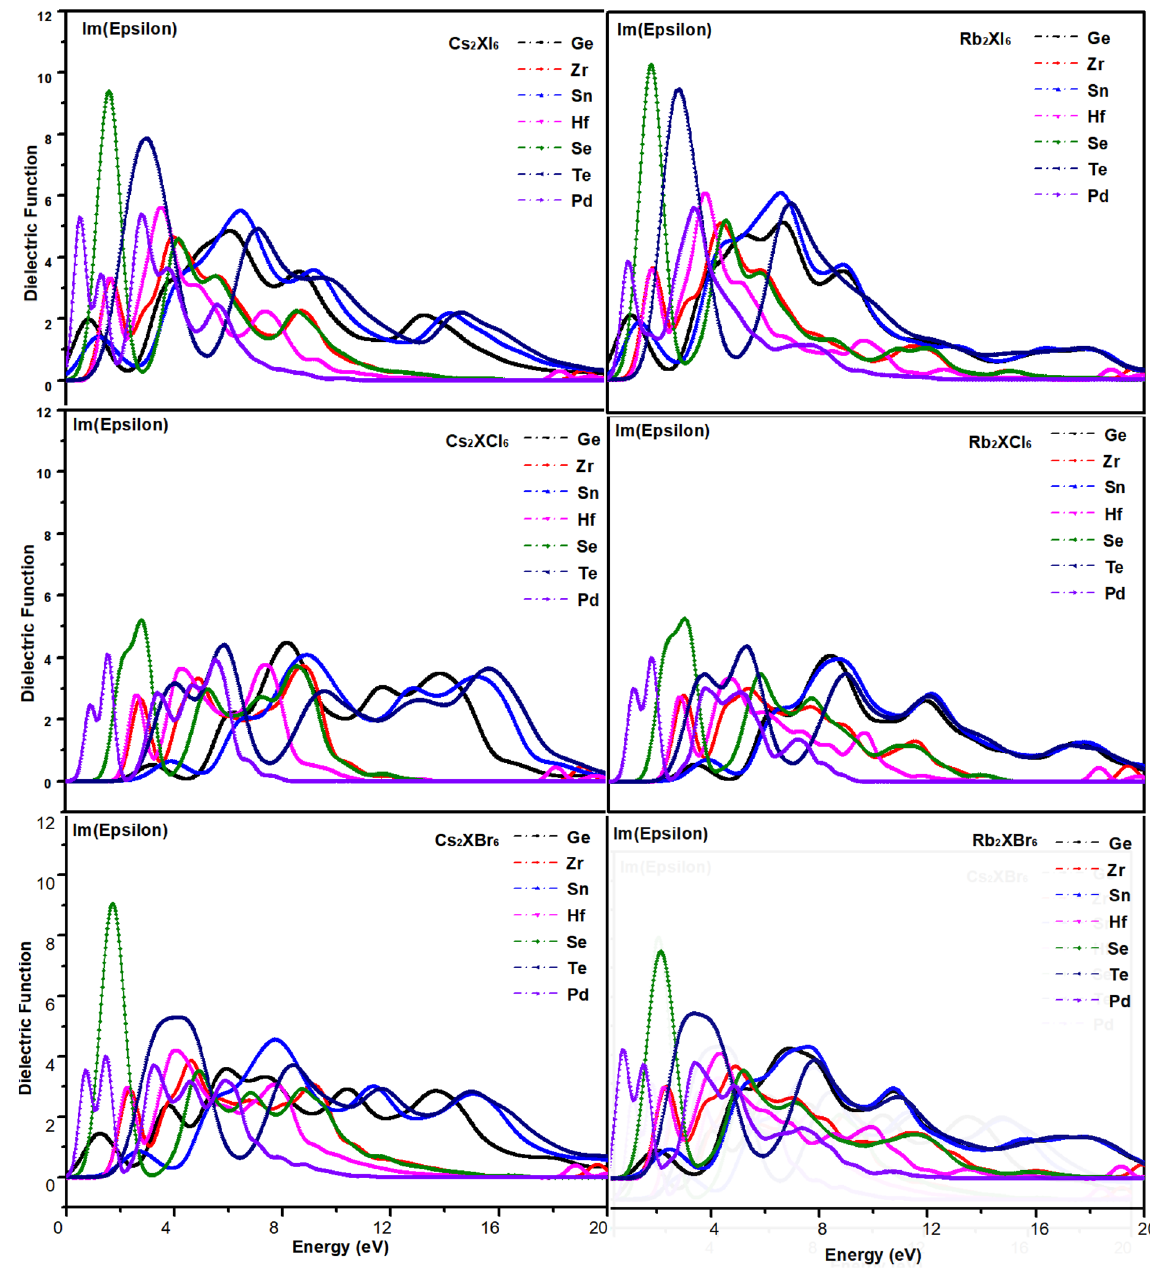
Figure 9. Imaginary part characteristic curve of